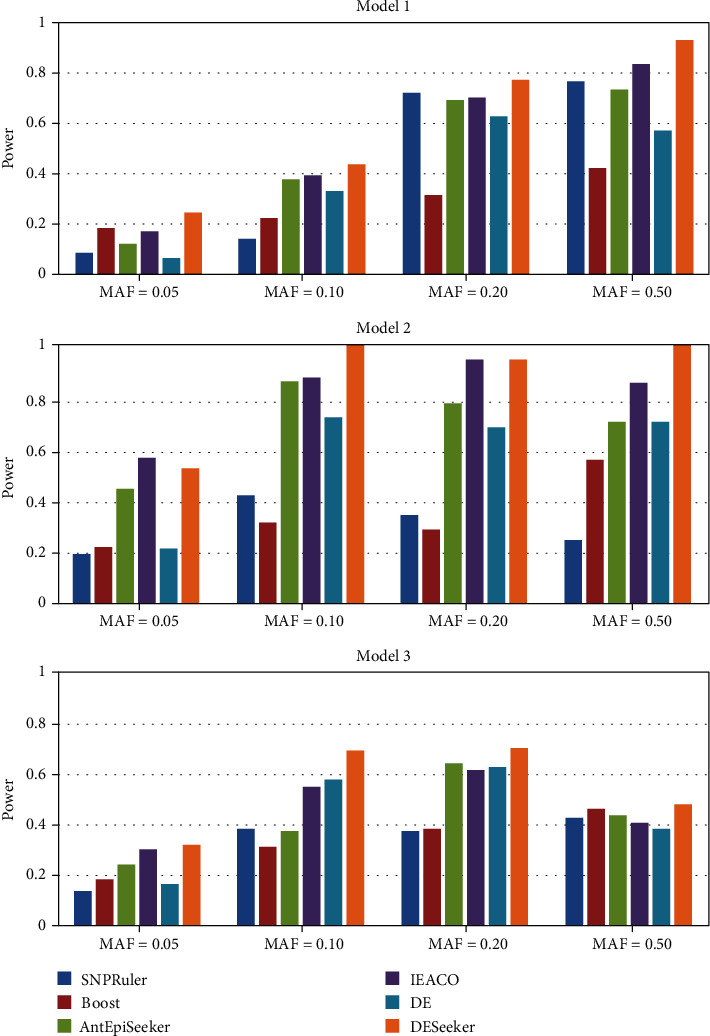
The framework of MA.